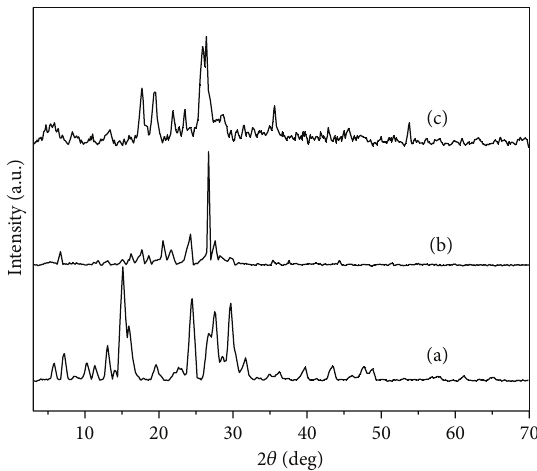
Figure 3: XRD patterns of isomers of aminophenol: (a) PoAP, (b) PmAP, and (c) PpAP.